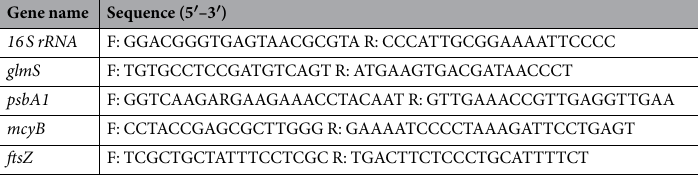
Table 2. Primers designed for qRT-PCR analysis. Reference Wu et al . 5